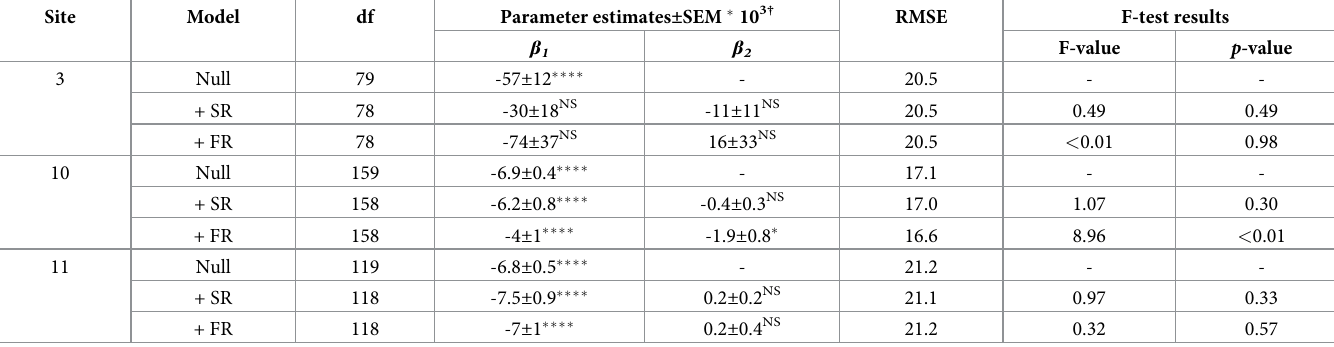
Table 5. Parameter estimates for the exponential model fitted to weed biomass reduction versus cover crop biomass for each site with and without the inclusion of cover crop species richness (+SR) and functional richness (+FR) as a predictive variable along with F-test results. A significant value of β sity affects the relationship between weed biomass reduction and cover crop biomass.